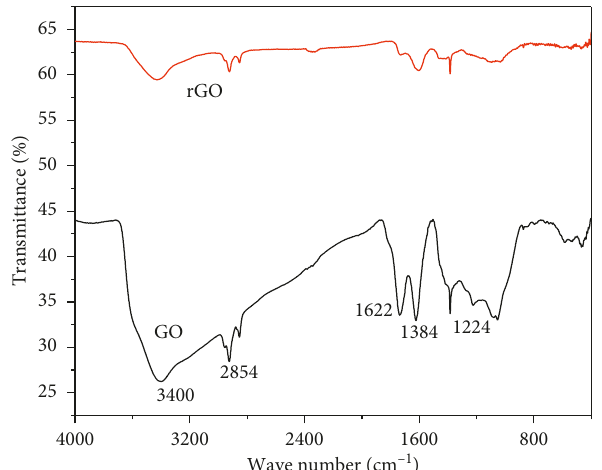
Figure 5: FTIR spectra of GO and rGO.